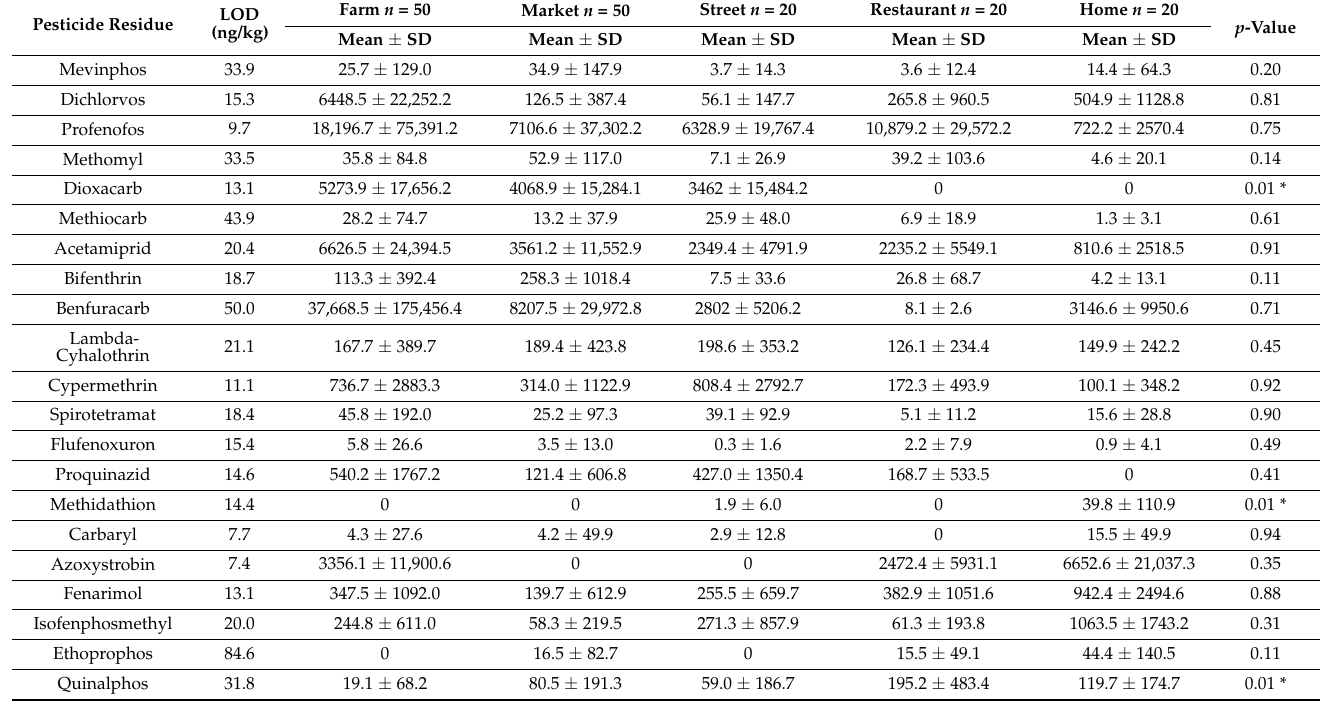
Table 2. Pesticide residue concentration trends in fruit and vegetable from farm to farm along the supply chain in